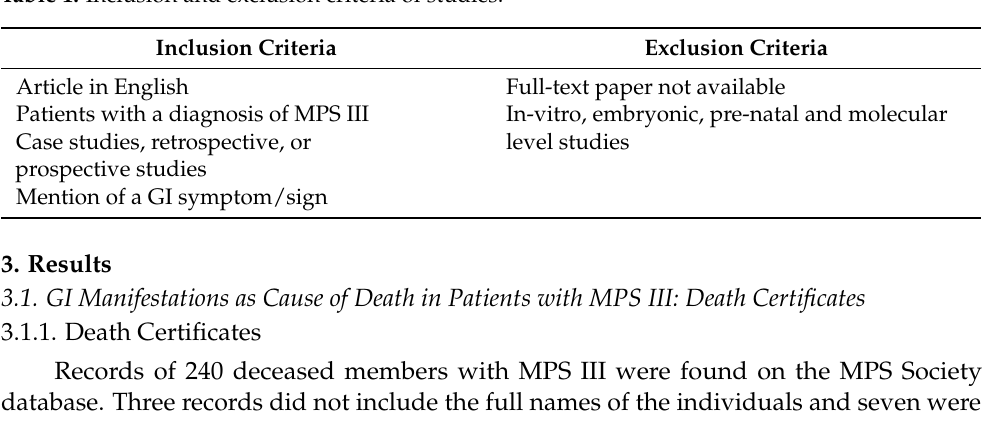
Table 1. Inclusion and exclusion criteria of